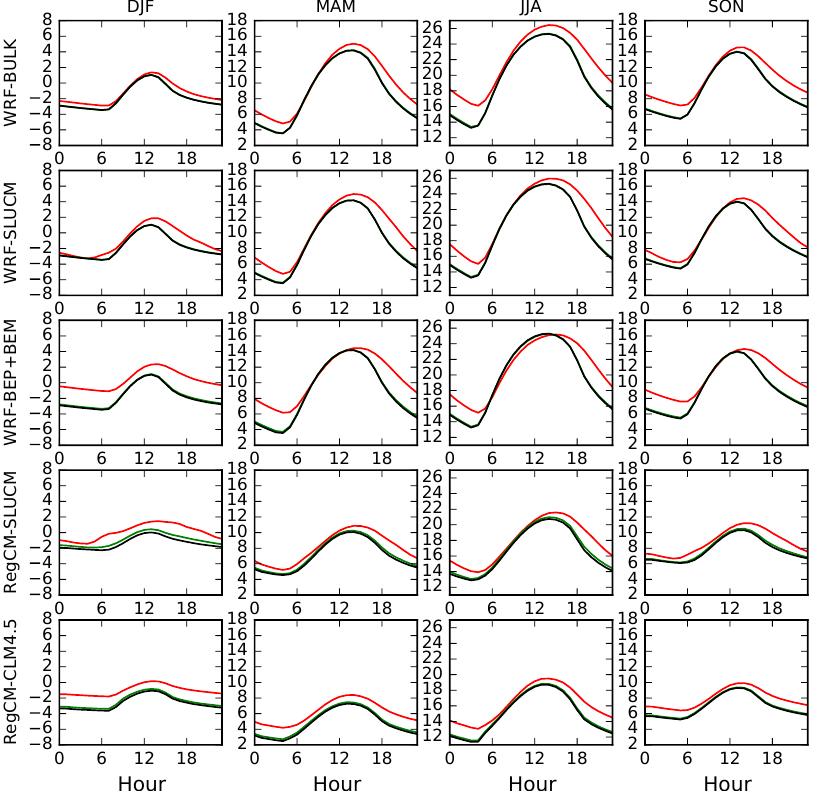
Figure 9. Averaged daily temperature cycles ( ◦ C) in the Prague city centre (red), in its surroundings (green) and those simulated with the urban surface removed